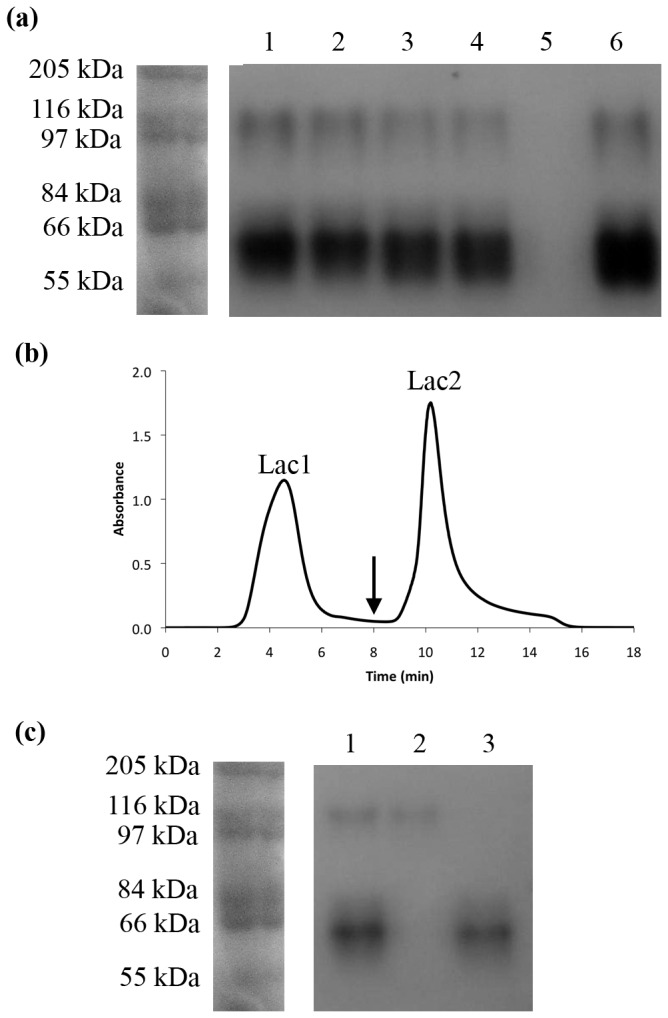
Purification of lacasses produced by submerged culture of

T

. pubescens
 using coffee husk as substrate.All samples were analyzed by SDS-PAGE under non-reducing conditions and stained with ABTS. No heat denaturation of the samples was conducted. (a) The crude extract (1) was centrifuged and filtered through a Whatman No. 1 filter (2), 0.45 µM membrane (3) 0.22 µm membrane (4), and ultrafiltrated through a 10 kDa cut-off membrane, permeate (5) and retentate (6). (b) UF retentate was purified by anionic exchange chromatography. Lac1 represent the unbound fraction, while Lac2 represent the eluted fraction. The arrow shows the point when protein elution was started. (c) Purified fractions (1) crude extract, (2) Lac1 and (3) Lac2. MW: Molecular Weight. Similar results were observed for crude extracts produced by using soybean pod husk and cedar sawdust.